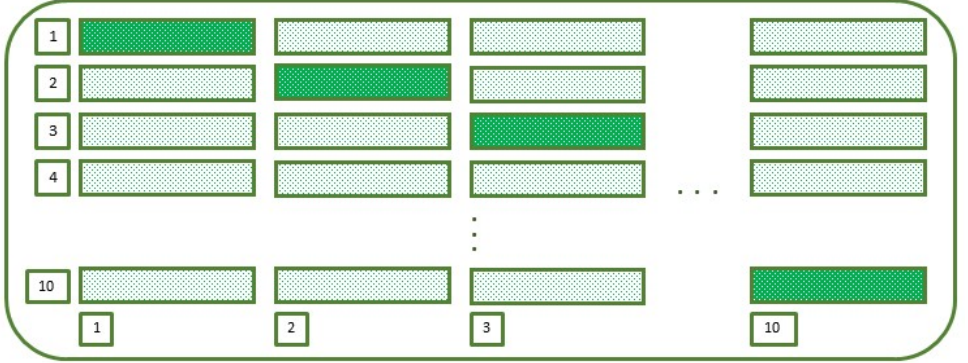
Figure 10. K-fold Cross-Validation Evaluation with K = 10. Using K-fold cross-validation evaluation for ten runs, the performance indices of accuracy , precision , recall , F1-Score and AUC-ROC were observed for the SVM, KNN